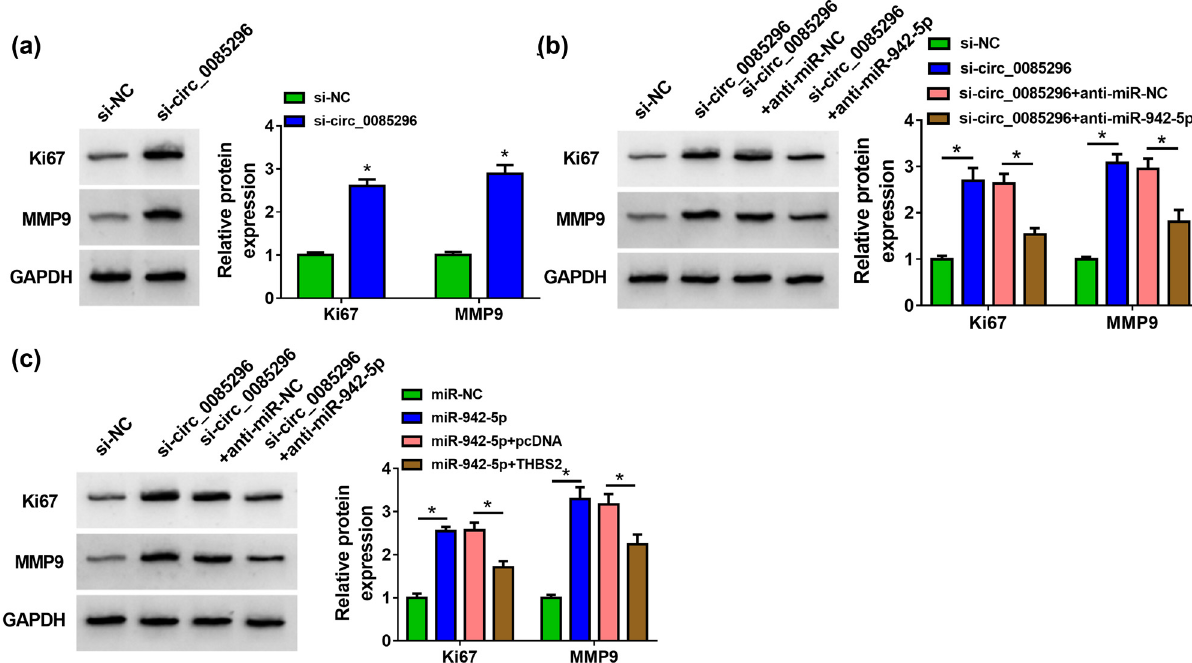
Figure A1: E ff ects of circ_0085296/miR - 942 - 5p/THBS2 on Ki67 and MMP9 protein expression. ( a ) The Ki67 and MMP9 protein expression in HTR - 8/SVneo cells transfected with si - NC or si - circ_0085296 was measured by WB analysis. ( b ) The Ki67 and MMP9 protein expression was determined by WB analysis in HTR - 8/SVneo cells co - transfected with si - circ_0085296 and anti - miR - 942 - 5p. ( c ) WB analysis was used to detect Ki67 and MMP9 proteins ’ expression in HTR - 8/SVneo cells co - transfected with miR - 942 - 5p mimic and THBS2 overexpression vector. * P <